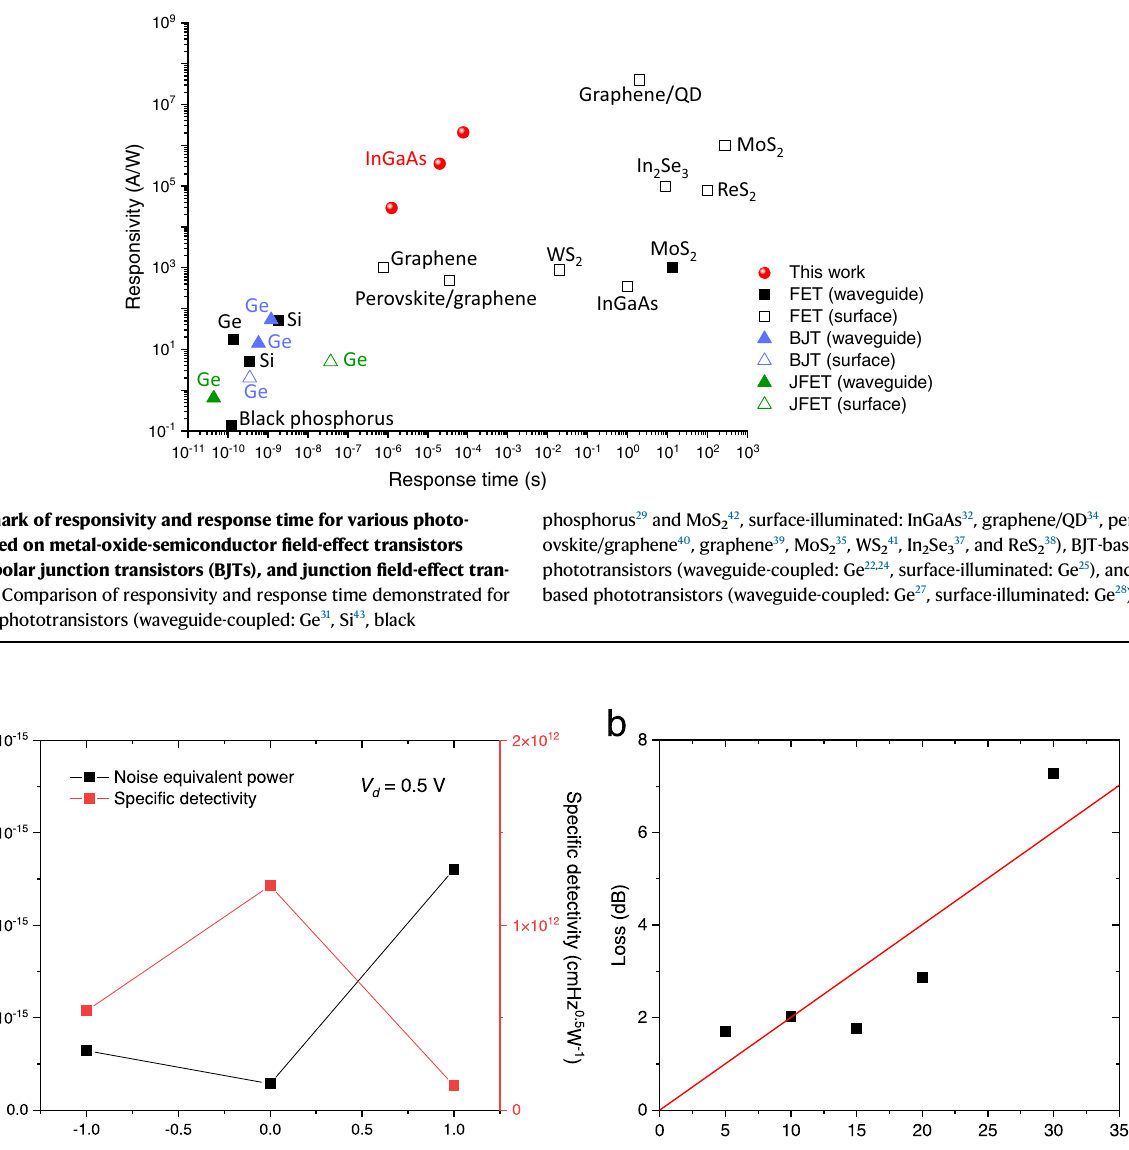
Fig.6|Evaluationofnoiseequivalentpower,speci fi cdetectivity,andinsertion loss. a Measured noise equivalent power and speci fi c detectivity of waveguide- coupled InGaAs phototransistor. The noise equivalent power was extracted from themeasurednoisepowerdensityspectrumwithvariedgatevoltageswhen V d was